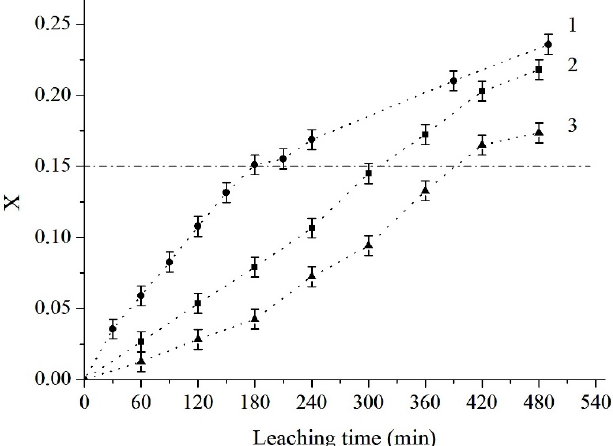
Figure 5. Dependence of the titanium leaching degree on the time of the ground altered ilmenite processing at a temperature of 100 °C and acid concentrations: 85 wt% (1), 90 wt% (2), 96 wt% (3). The dashed line shows the degree of conversion at which the reaction mixture solidifies.